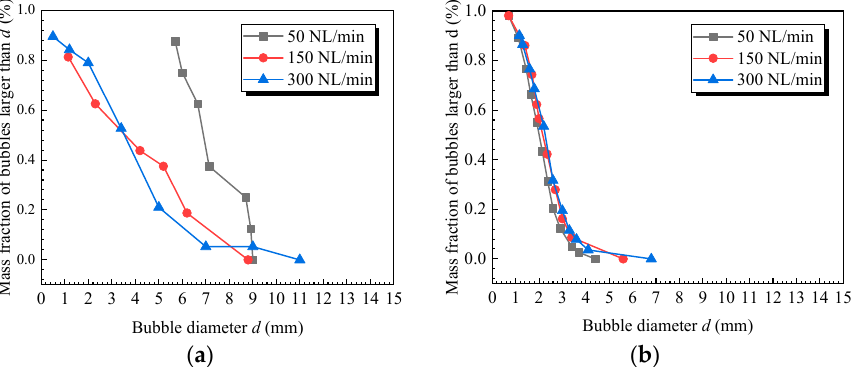
Figure 7. Bubble distribution curve in the ladle with different plugs: ( a ) slot plug and ( b ) porous plug.